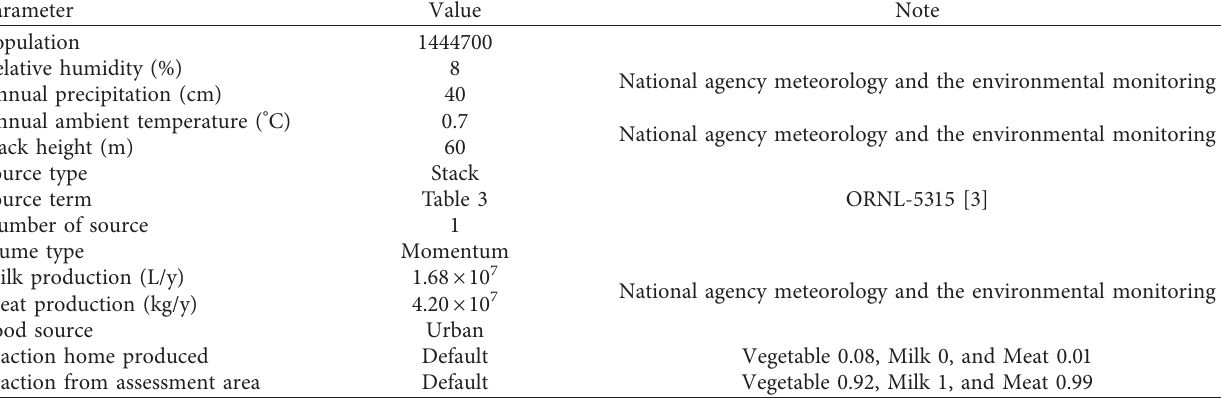
Table 4: Input parameters for